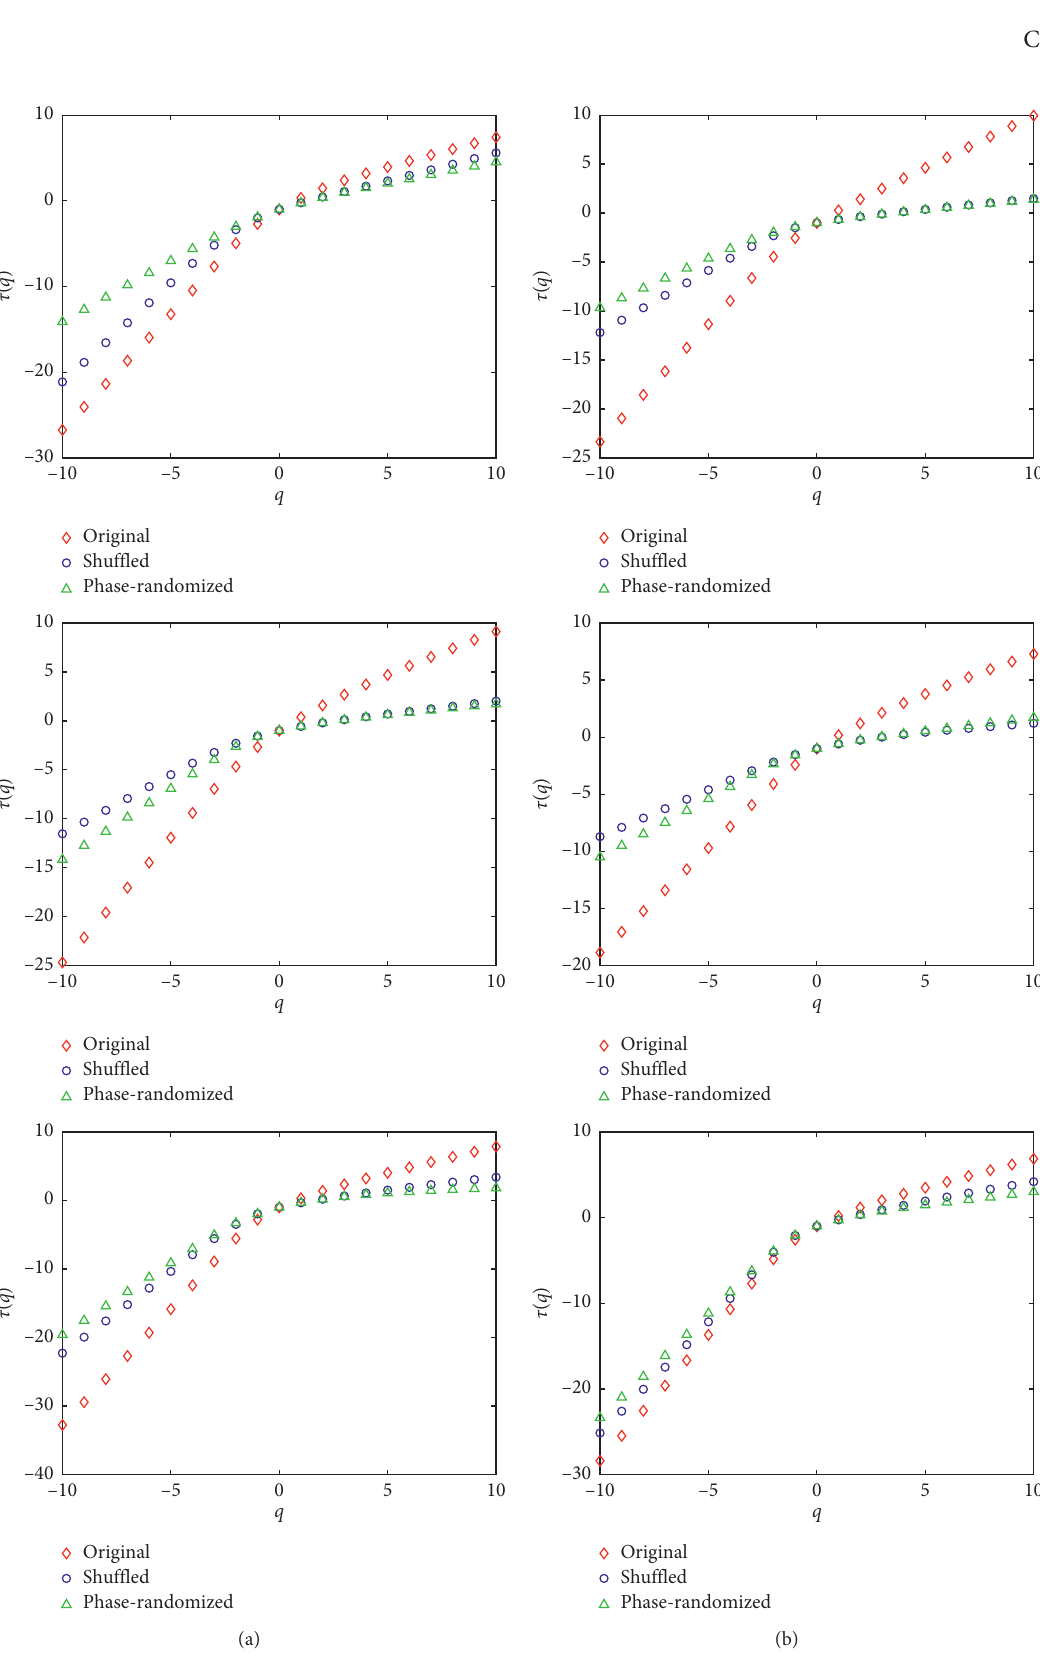
Figure 13: Renyi exponent (a) before law and (b) after law. From top to bottom are Seoul, Busan, and